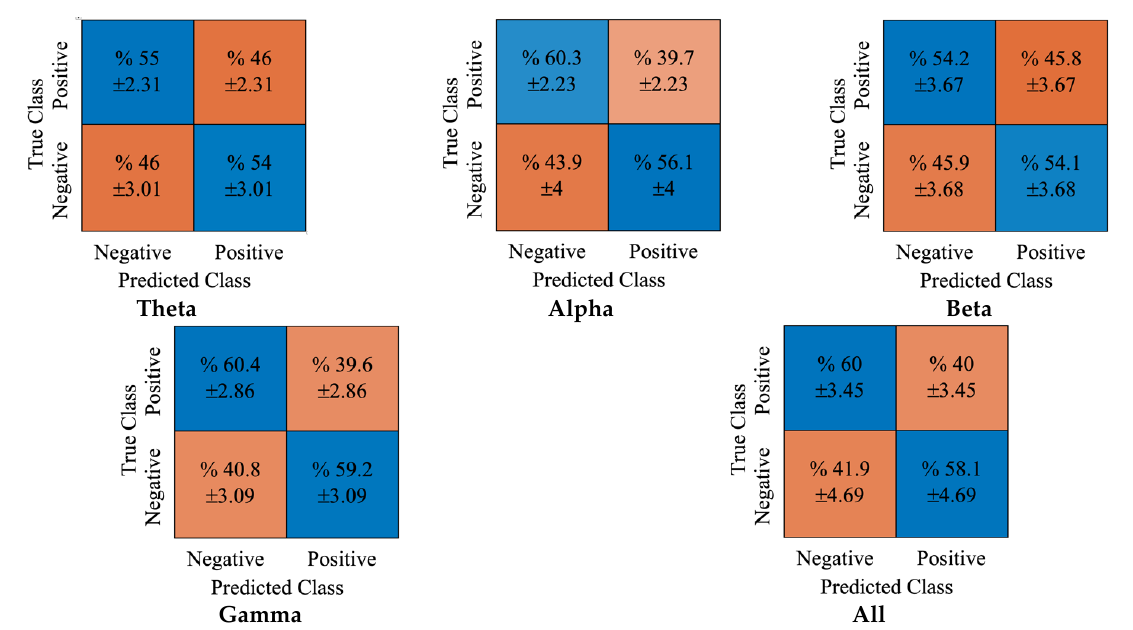
Figure 6. The obtained confusion matrices for DE features and kNN classifier. Similarly, Figure 7 shows the obtained confusion matrices for the NB classifier. Again, the true classification accuracies for positive and negative classes for the gamma rhythm were 60.4% and 59.2%, respectively.